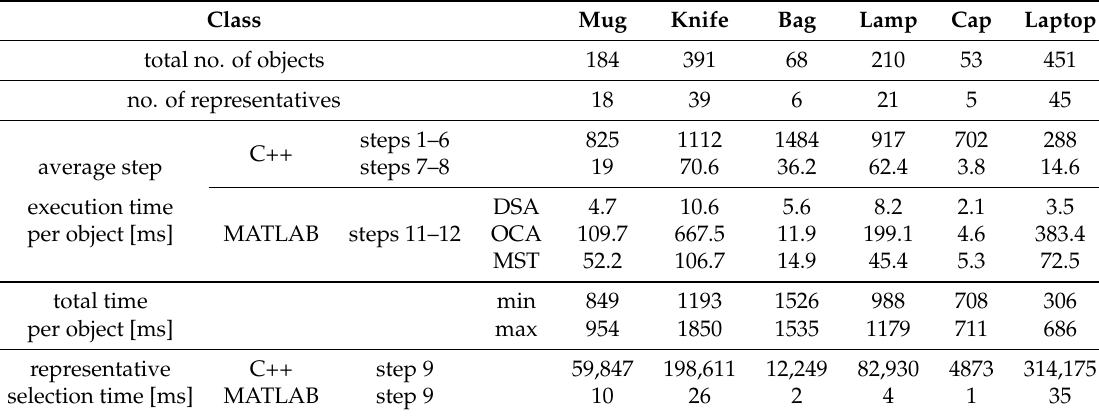
Table 4. Running time of the automatic component